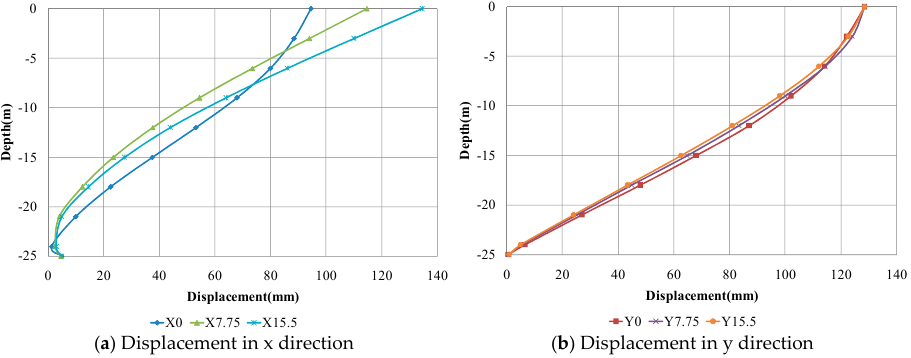
Figure 5. Displacements of selected different distance piles assuming a hinged connection between the piles and the reinforced concrete plate of the platform.